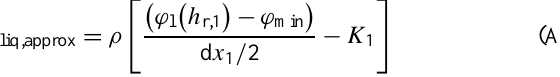
grassland Temperate grassland Cool temperate/ warm temperate/ Mediterranean/desert